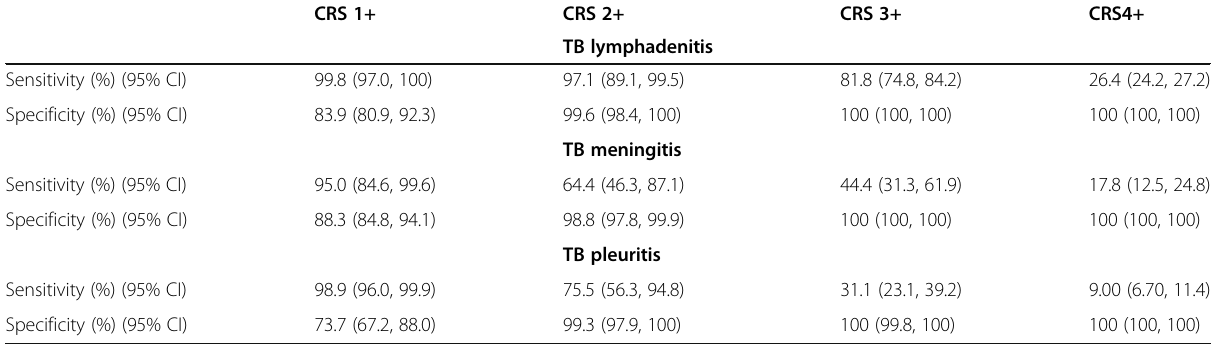
Table 3 Diagnostic accuracy of a series of composite reference standards for each form of extrapulmonary TB